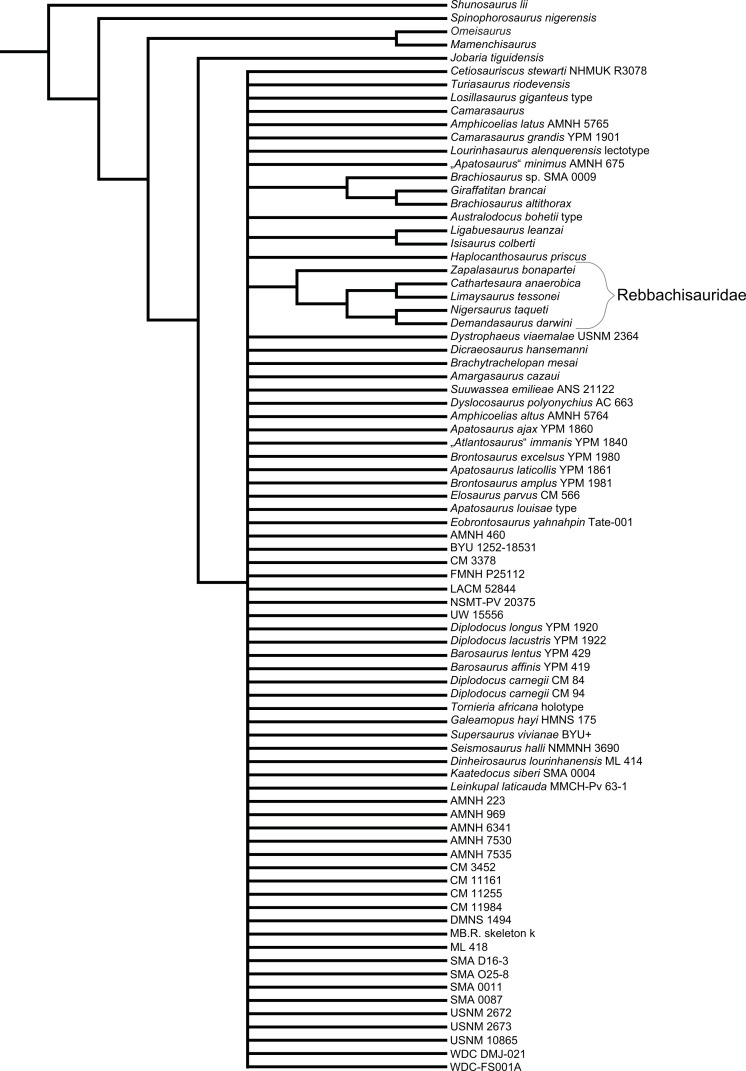
Strict consensus tree of the complete analysis with equal weighting.OTUs with species names and specimen numbers are type specimens. Tree length is 1,976 steps.